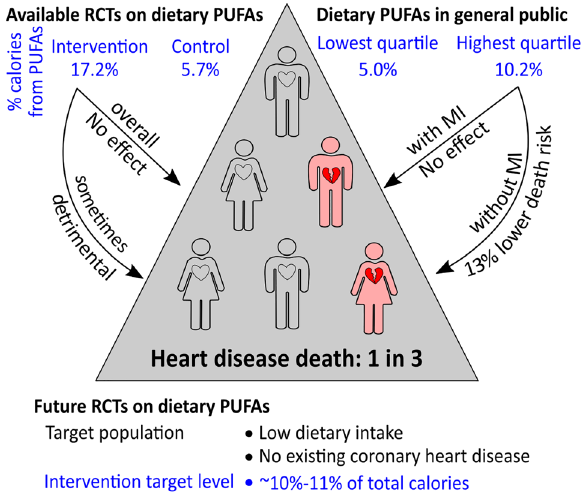
Figure 2. Suggestions for future randomised controlled trials (RCTs) investigating dietary polyunsaturated fatty acids (PUFAs) on heart disease mortality. Available RCTs suggest that dietary PUFAs may not protect against heart disease mortality overall. However, those trials used high doses of dietary PUFAs, which do not likely mimic diet in the general public, and the high doses of dietary PUFAs used in many RCTs might have toxic effects. Some meta-analysis reports showed that increasing dietary intake of PUFAs in RCTs failed to show protection against heart disease mortality. Our results showed that, in people from the general public who did not have a prior diagnosis of myocardial infarction (MI), those with PUFA intake in the highest quartile had a 13% lower heart disease mortality risk compared to those in the lowest quartile. Future RCTs could target those without established coronary heart disease and with low dietary PUFA intake, with the intervention to increase PUFA intake to more modest levels ( e.g ., 10–11%, equivalent to the mean level in the highest quartile of our